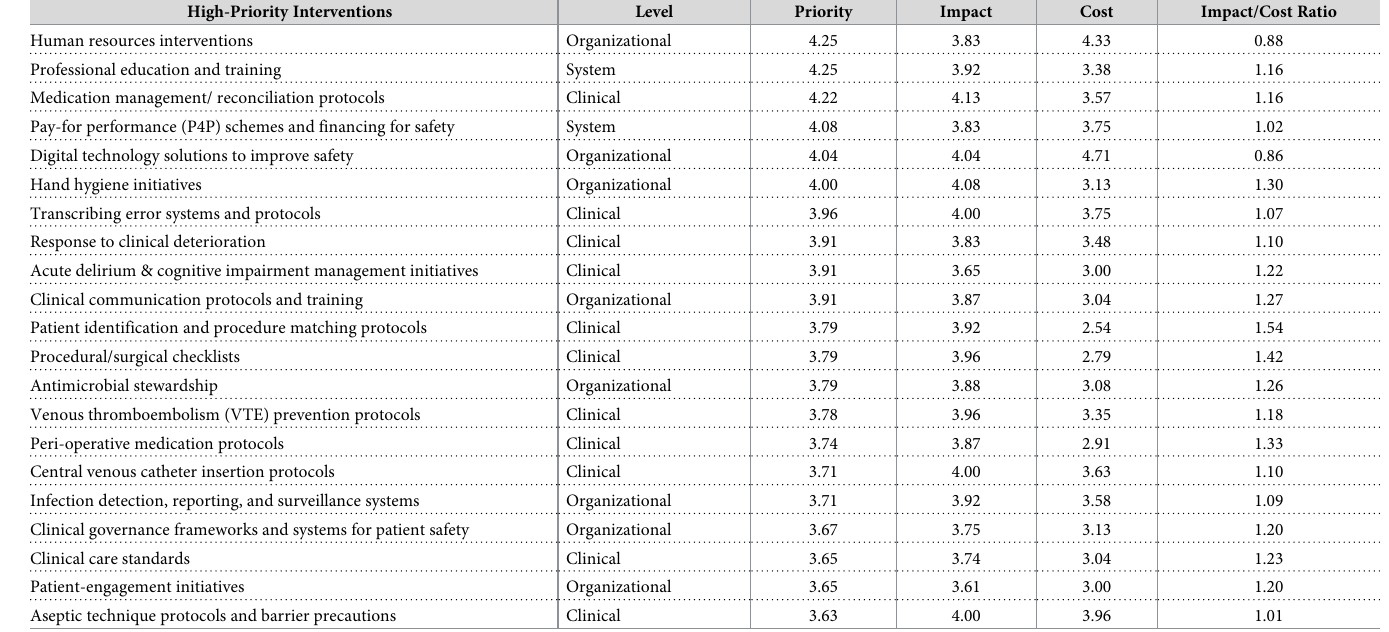
Table 4. Priority, impact, and cost of interventions (ordered by